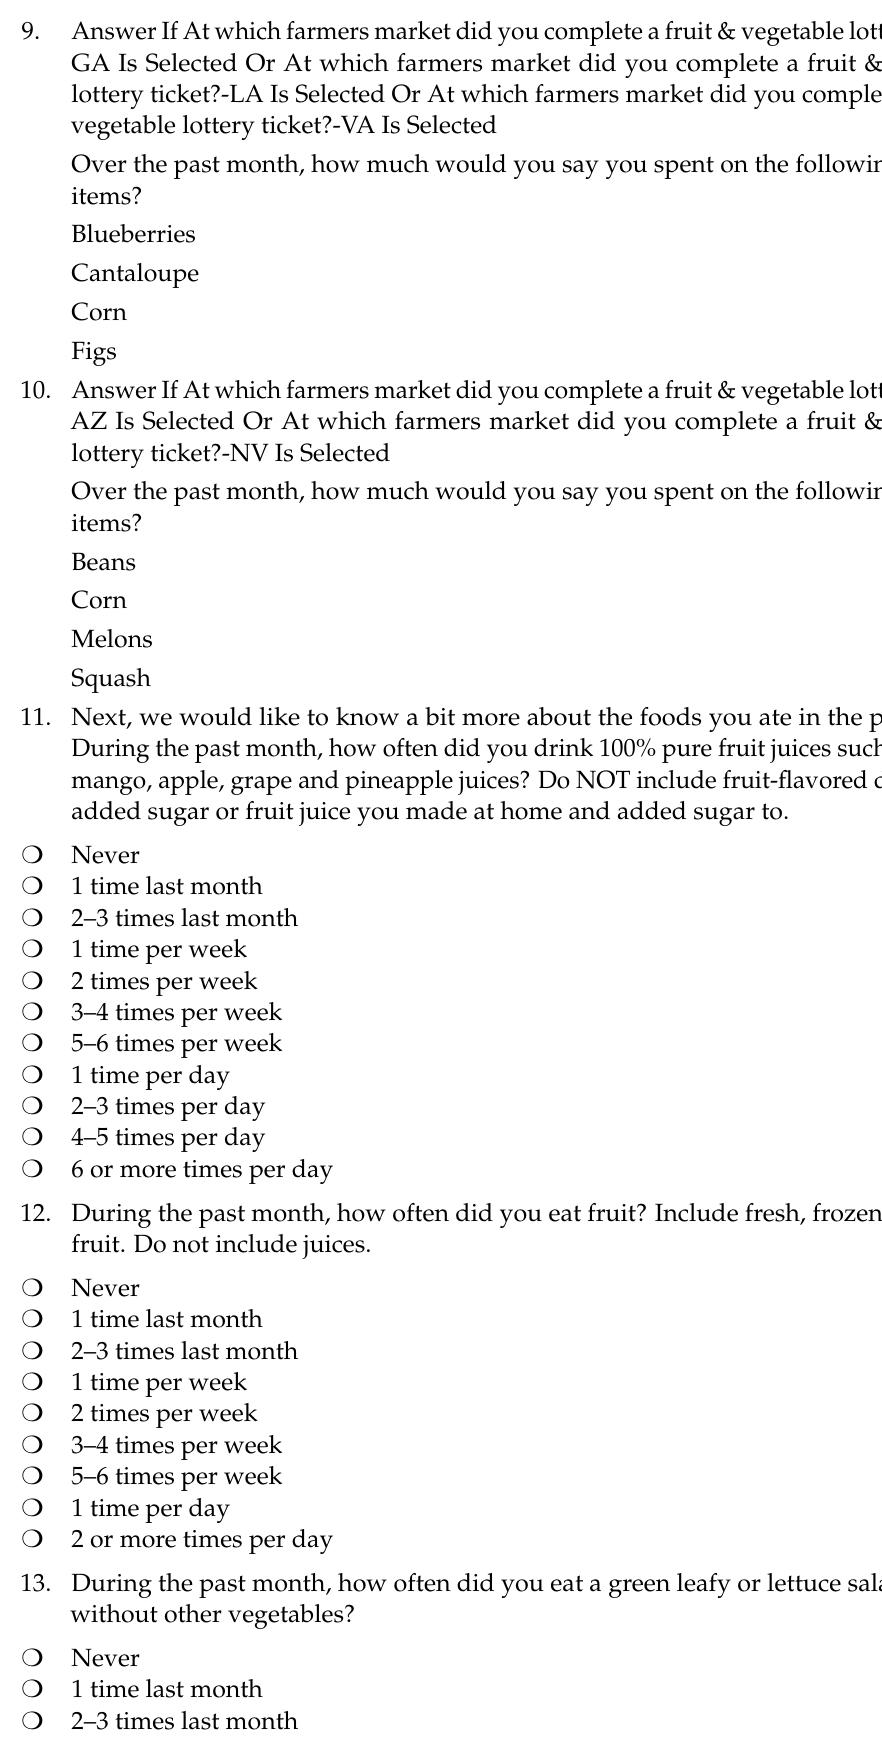
9. Answer If At which farmers market did you complete a fruit & vegetable lottery ticket?- GA Is Selected Or At which farmers market did you complete a fruit & vegetable lottery ticket?-LA Is Selected Or At which farmers market did you complete a fruit & vegetable lottery ticket?-VA Is Selected Over the past month, how much would you say you spent on the following produce items?